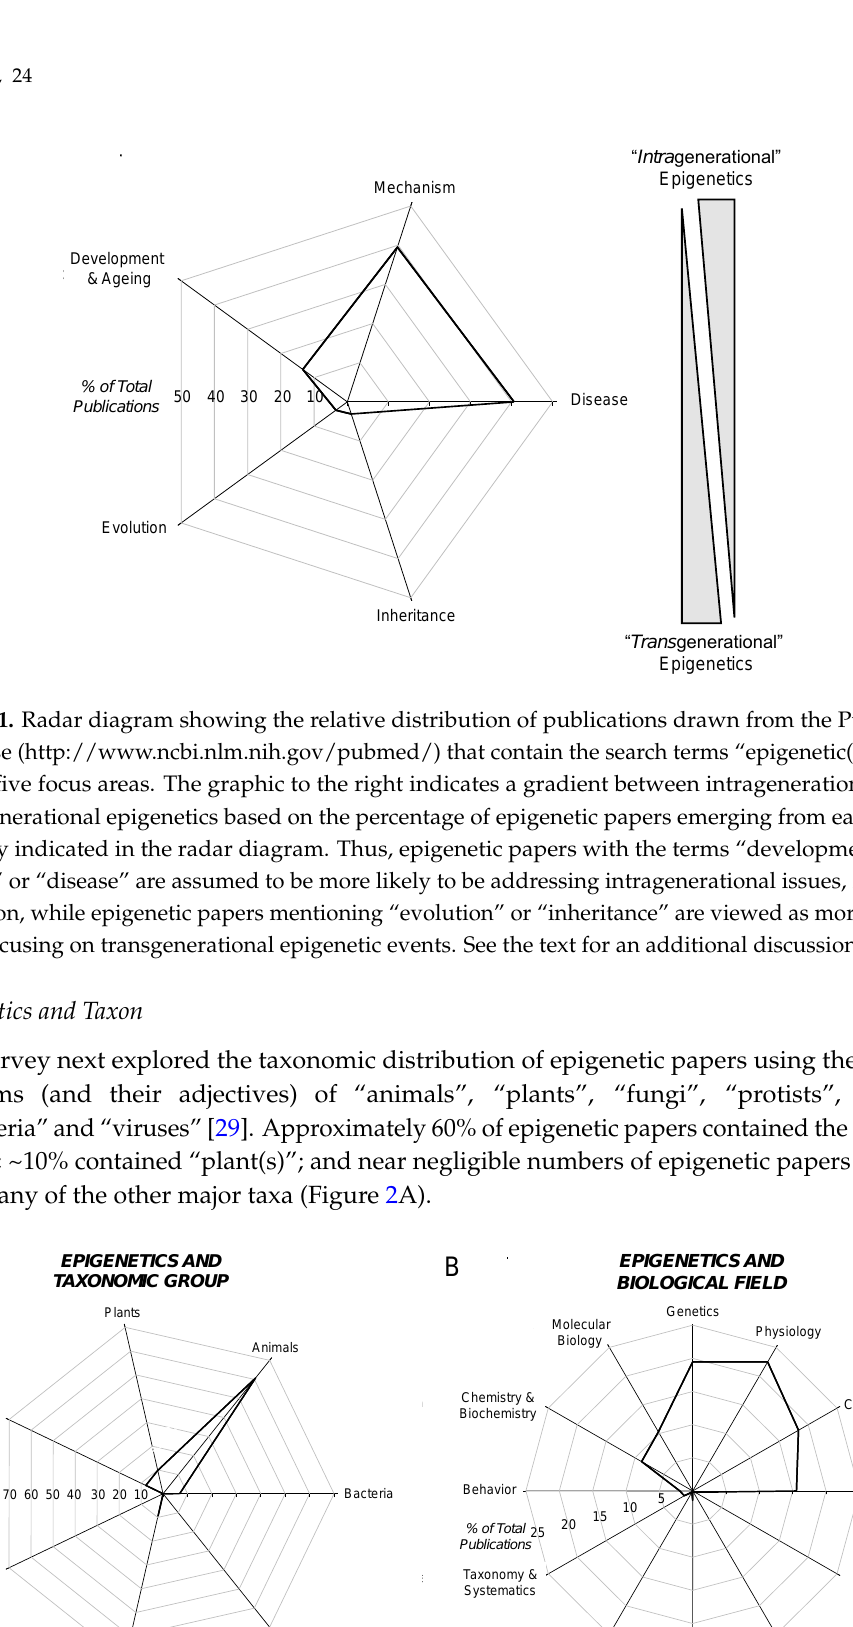
Figure 2. Radar diagram showing the relative distribution of publications on epigenetics drawn from the PubMed database (http://www.ncbi.nlm.nih.gov/pubmed/). ( A ) distribution of publications that contain the search terms “epigenetic(s)” and one of seven biological taxa; ( B ) distribution of publications that contain the search terms “epigenetic(s)” and one of 12 biological fields.